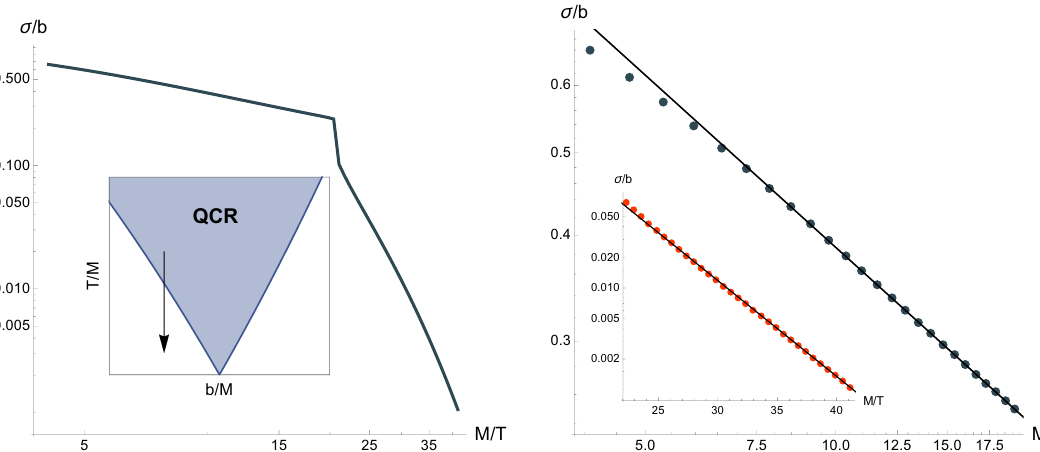
Figure 5 . Left: log-Log plot of the AHC (cid:27) vs M=T very close to the critical point (cid:22) b = 1 : 4023. For small enough M=T ’ 20 the function (cid:12)ts very well a power law ( M=T ) (cid:0) (cid:23) with (cid:23) = 0 : 673. At low enough temperature we abandon the critical region and the behaviour is no longer a power law as depicted in the inset. Right: log-log zoom on the region M=T / 20 shown in the left panel and (cid:12)t (black line). In the inset we show a log plot for M=T ’ 20, where an exponential decay is recovered. Black line corresponds to the (cid:12)t to c 1 e c 2 M=T .